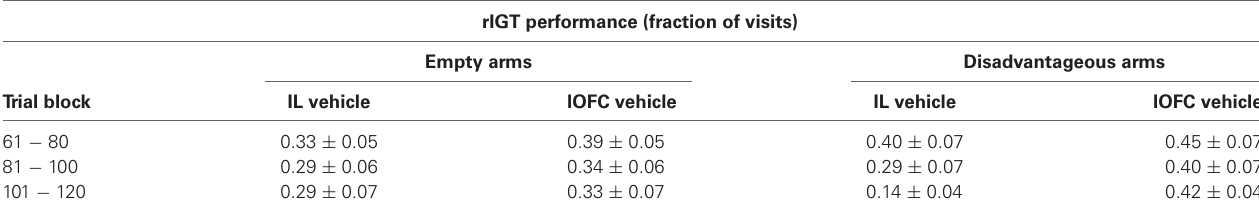
Table 1 | rIGT performance under treatment. Shown are means ( ± SEM) of fractions of visits to empty and disadvantageous arms of rats treated with vehicle in the infralimbic cortex (IL) or lateral orbitofrontal cortex (lOFC), for trial blocks 61–120 . rIGT performance (fraction of